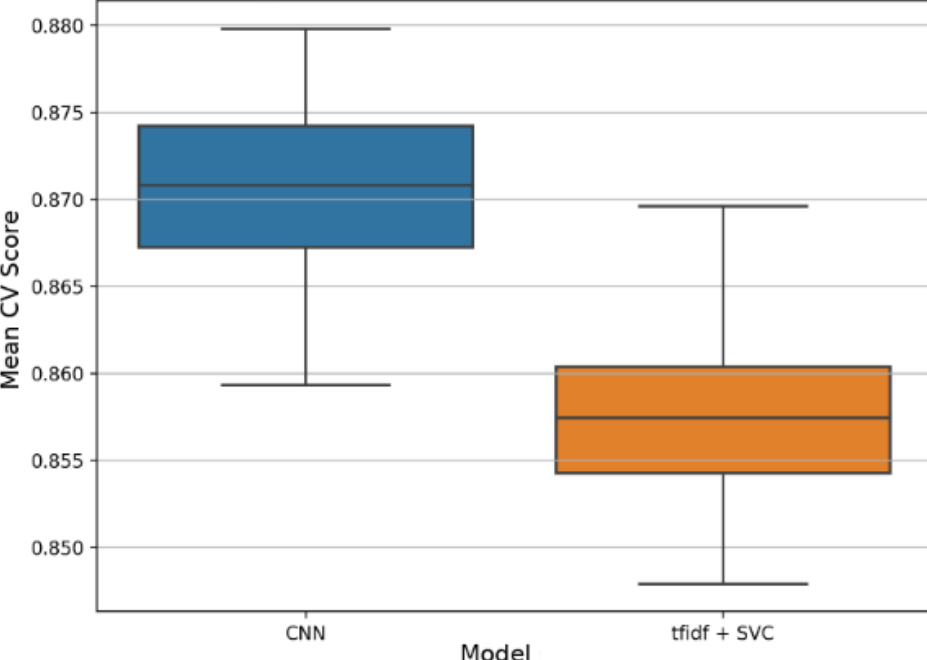
Figure 11. Comparison of Convolutional Neural Network and baseline model.